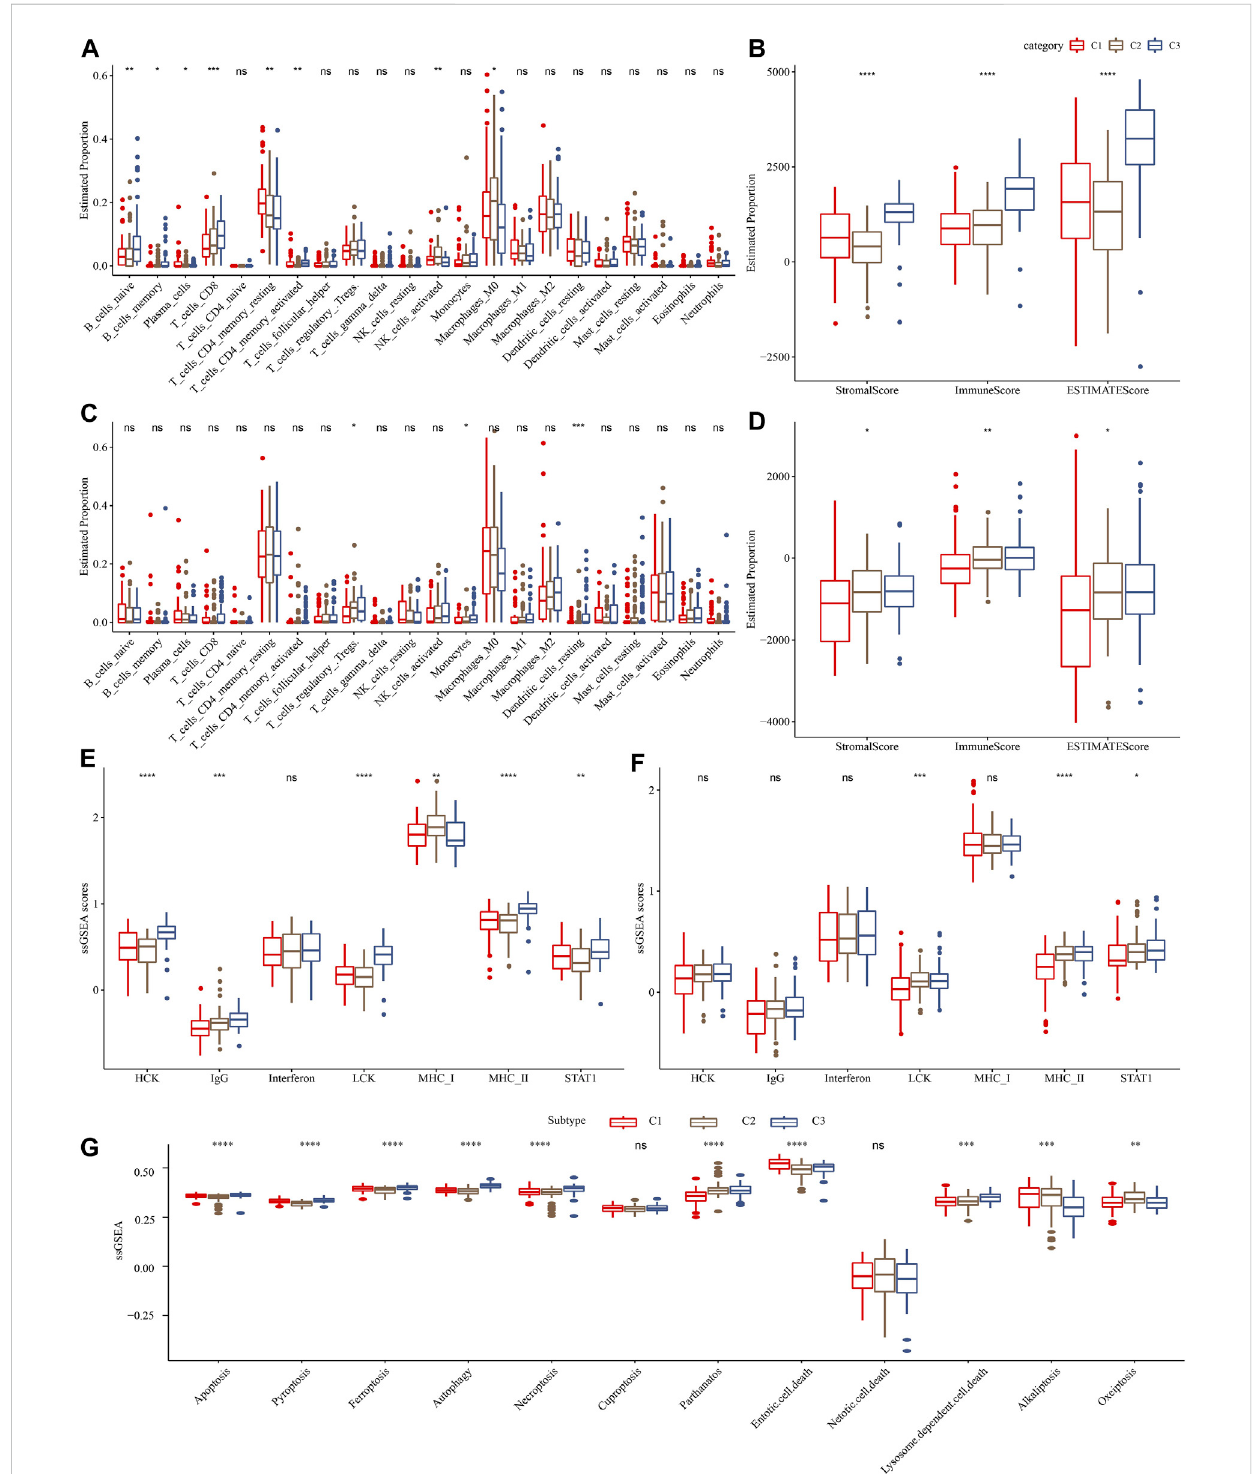
FIGURE 4 Comparisonofimmunein fi ltrationandin fl ammationactivityamongthreemolecularsubtypes. (A) and (C) representedthedifferencesintherelative abundance of 22 immune cells among different molecular subtypes in the TCGA-PAAD and PACA-CA cohorts, respectively. (B) and (D) represented the comparisonoftheESTIMETEresultsamongclustersintheTCGA-PAADandPACA-CAcohorts,respectively. (E) and (F) representedthedifferencesinthe in fl ammation activity among clusters in the TCGA-PAAD and PACA-CA cohorts, respectively. (G) The ssGSEA score differences of 12 programmed cell death patterns among 3 molecular